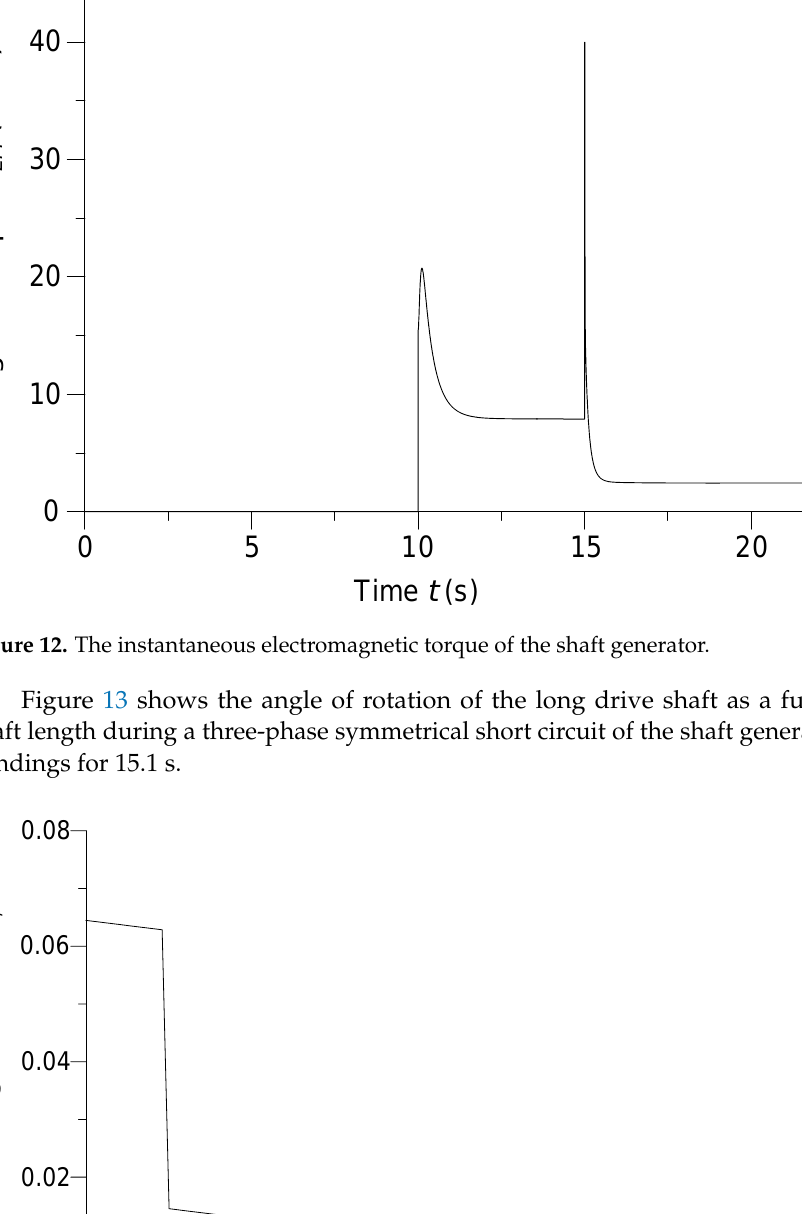
Figure 12. The instantaneous electromagnetic torque of the shaft generator.